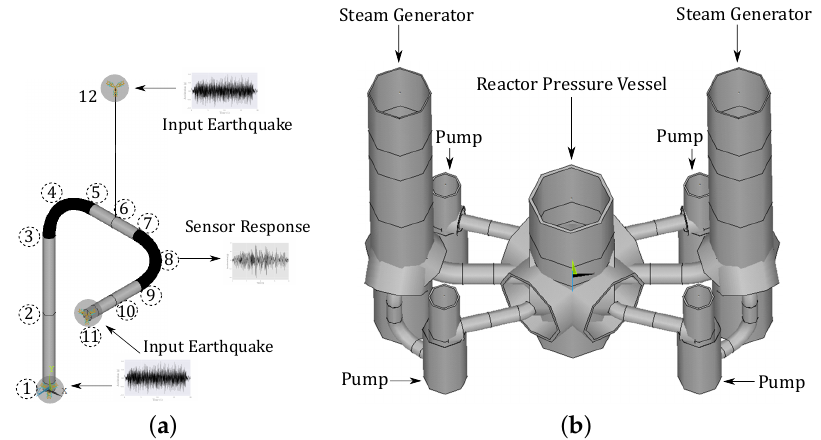
Figure 1. Nuclear piping-equipment systems [56]. ( a ) piping system 1; ( b ) piping system 2. In addition to damaged locations, it also featured the detection of damage